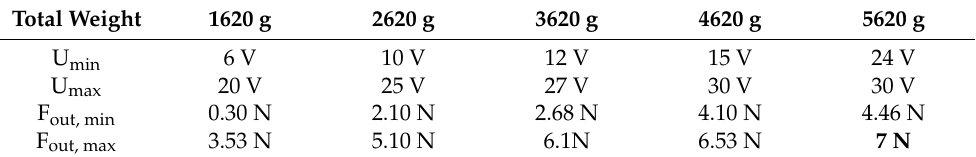
Figure 12. Measurement results of output force F out, − X of the planar motor platform. Table 4. Appropriate operating ranges for force in the − X direction.